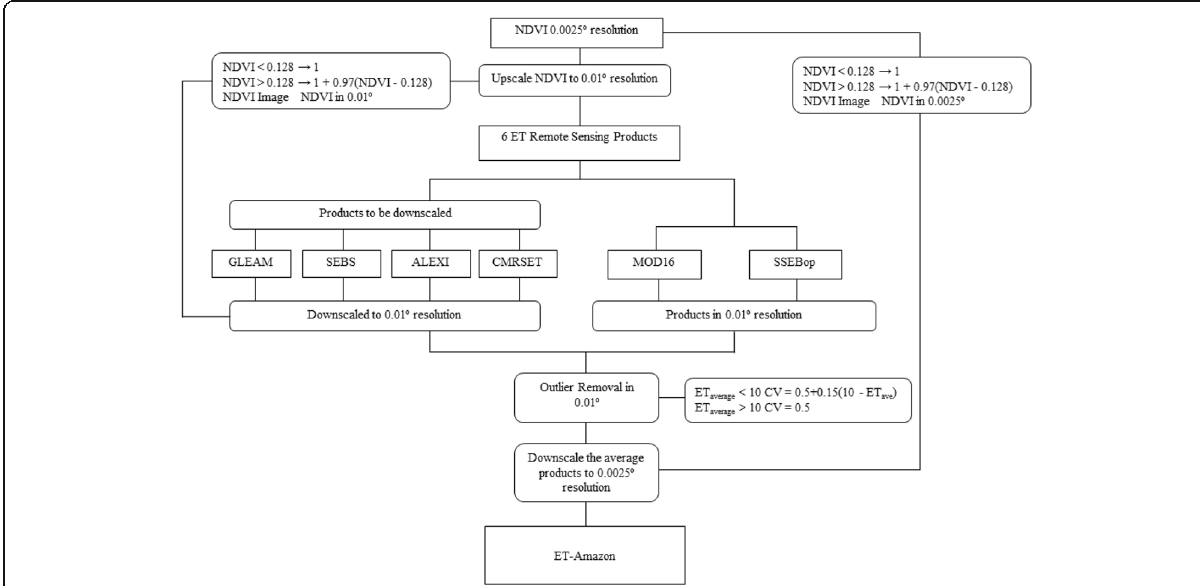
Fig. 3 Flowchart of the averaging procedure to merge six existing ET products (GLEAM, SEBS, ALEXI, CMRSET, MOD16, and SSEBop) into one product, i.e.,